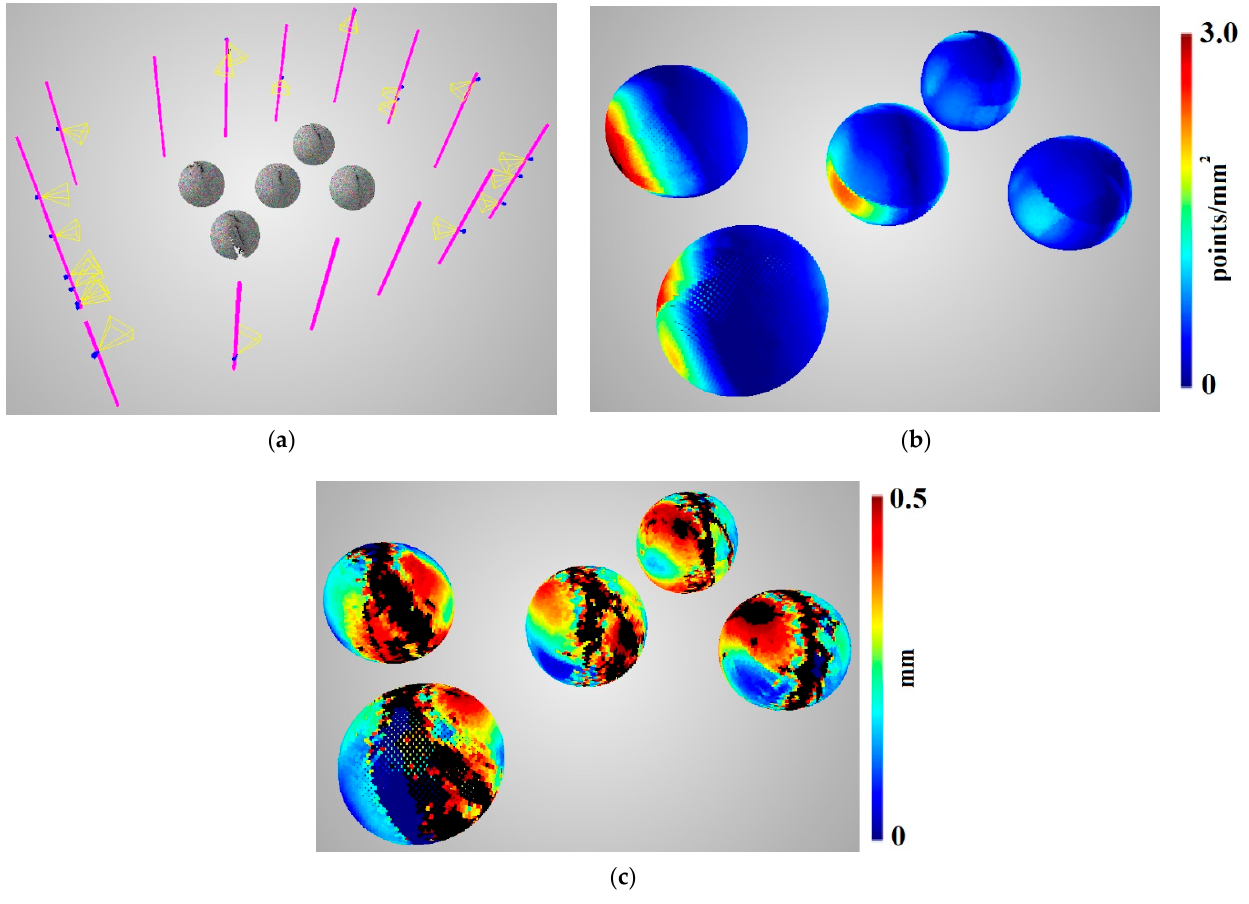
Figure 16. Average 360-degree scene with ( a ) 20-camera distribution and 5 reconstructed spheres in the measurement volume with ( b ) density and ( c ) accuracy evaluations. Values that are higher than 3.0 in ( b ) and 0.5 in ( c ) are marked in black.